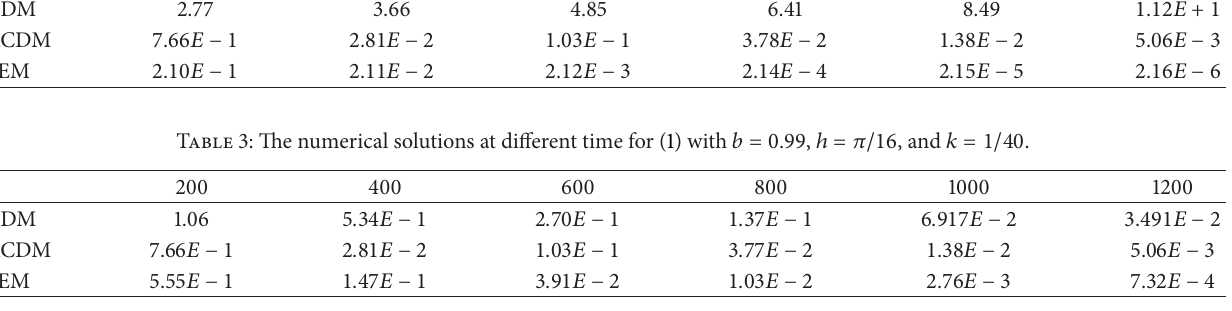
Table 2: The numerical solutions at different time for (1) with 𝑏 = 0.99 , ℎ = 𝜋/8 , and 𝑘 = 1/20 . 𝑡 200 400